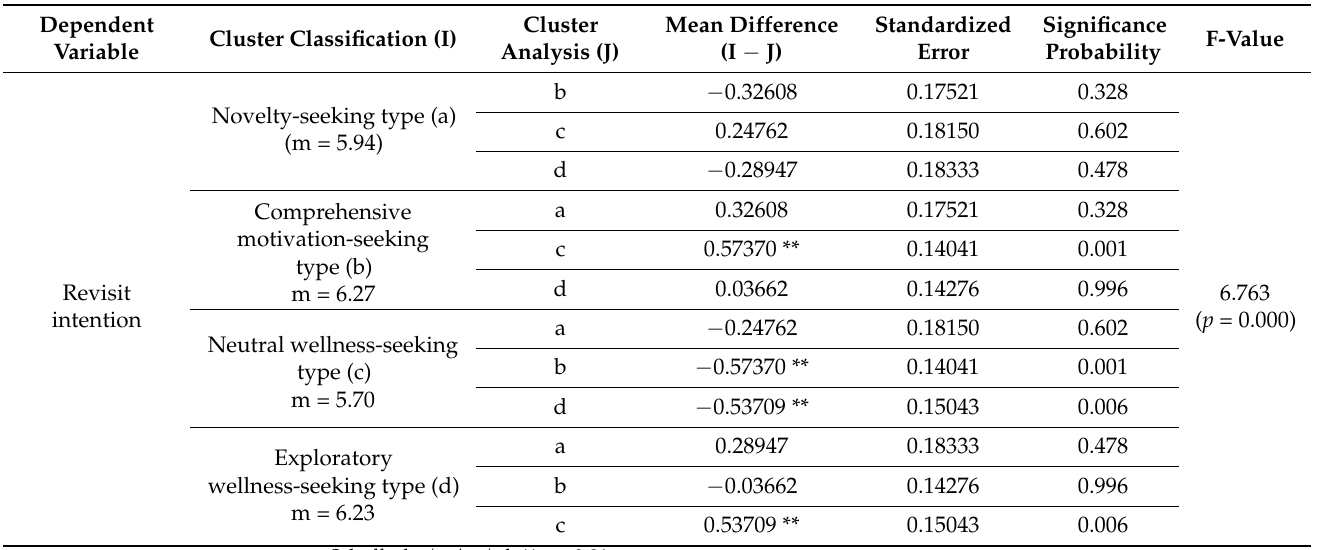
Table 14. Differences in means of intention to revisit among wellness tourism product participant groups.